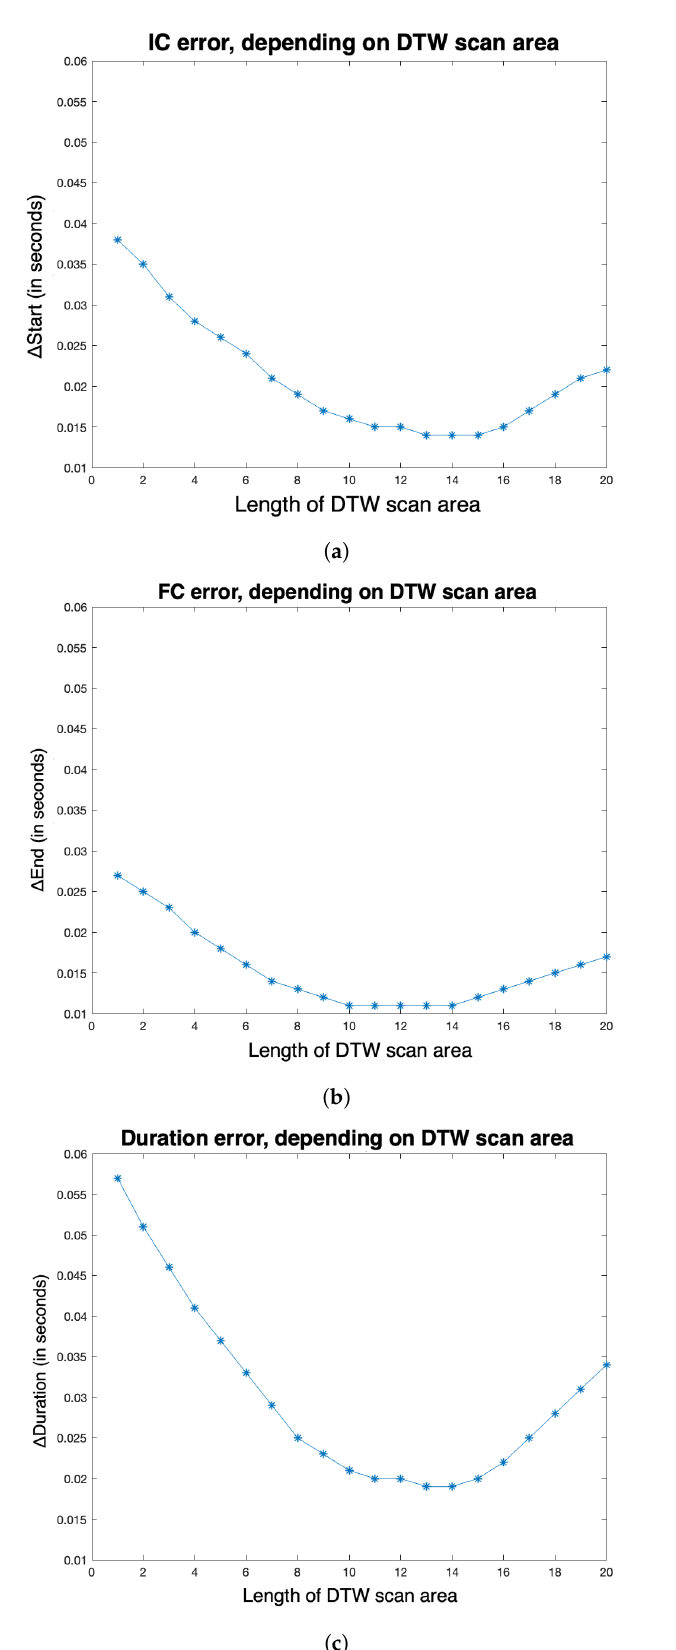
Figure 9. For strategy S5, influence of parameter z on the evaluation metrics ( a ) ∆ Start, ( b ) ∆ End and ( c ) ∆ Duration, for z varying from 1 to